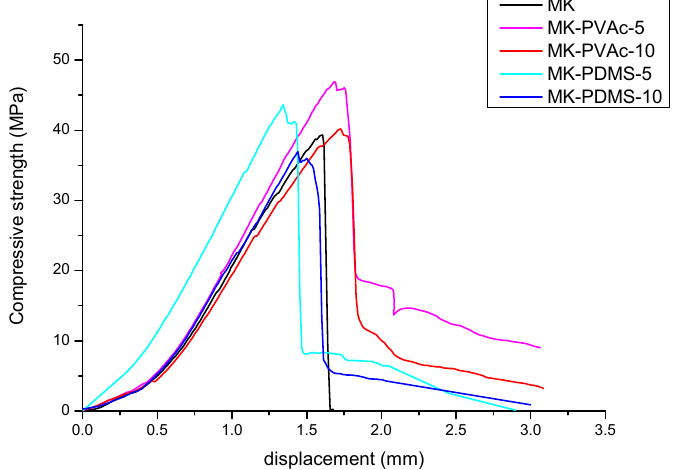
Figure 6. Compressive strength vs. displacement for samples: (black) MK; (pink) MK-PVAc-5; (red) MK- PVAc-10; (sky blue) MK-PDMS-5; (blue) MK-PDMS-10.